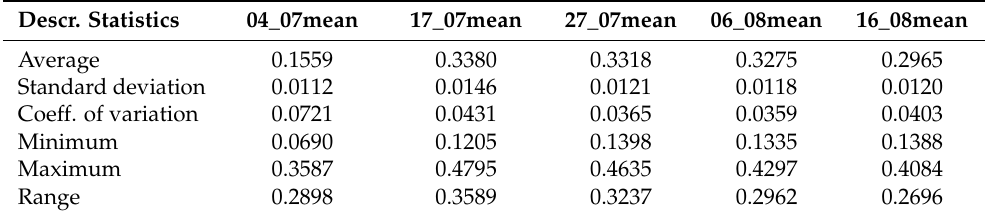
Table 10. The descriptive statistics of the MSAVI mean values across all pilot fields during each data collection date.